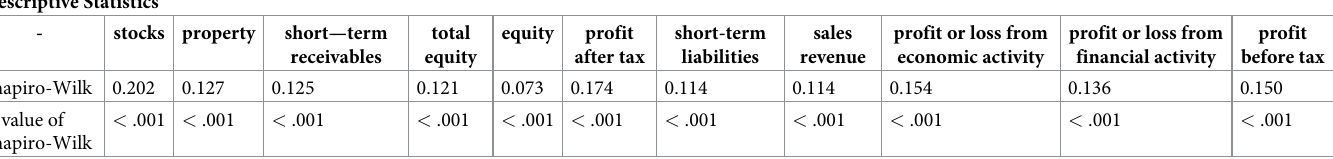
Table 2. Results of the Shapiro-Wilk